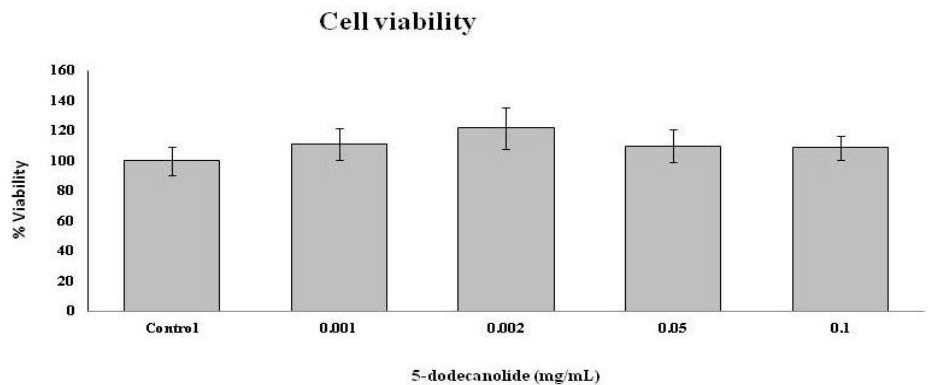
Figure 4. Antioxidant and anti-inflammatory effects of pork lard hydroalcoholic extract compounds neutrophils LPS-stimulated. CAT ( A ); MPO ( B ). Statistical analysis: One-way ANOVA test. Different letters indicate significant dif- ferences between the treatmnets ( p < 0.05).